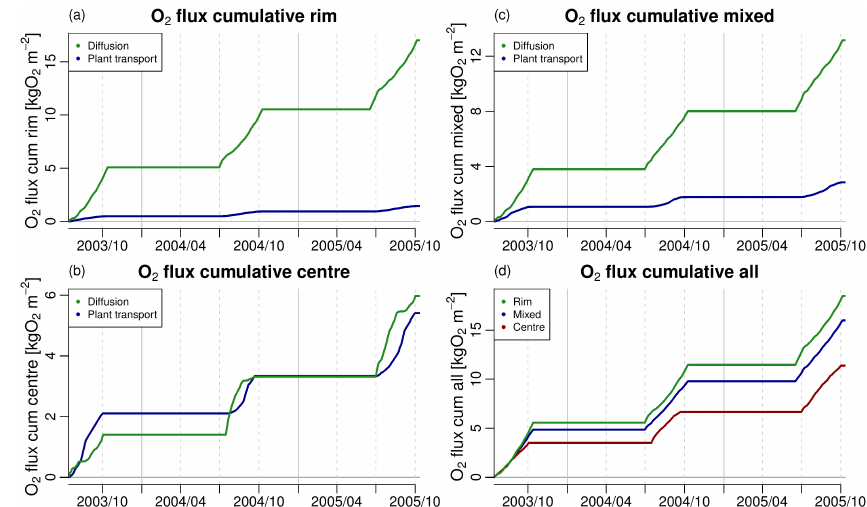
Figure B6. Modelled oxygen flux into soil at (a) the rim, (b) the centre, (c) a mixed approach of 65% rim plus 35% centre, split into the different transport processes, and at (d) the rim, the centre and a mixed approach of 65% rim plus 35% centre combined, as a cumulative sum. Solid lines indicate 1 January; dashed lines indicate 1 April, 1 July and 1 October of the respective year. Please note the different scales. Table B1 gives the maximal values.